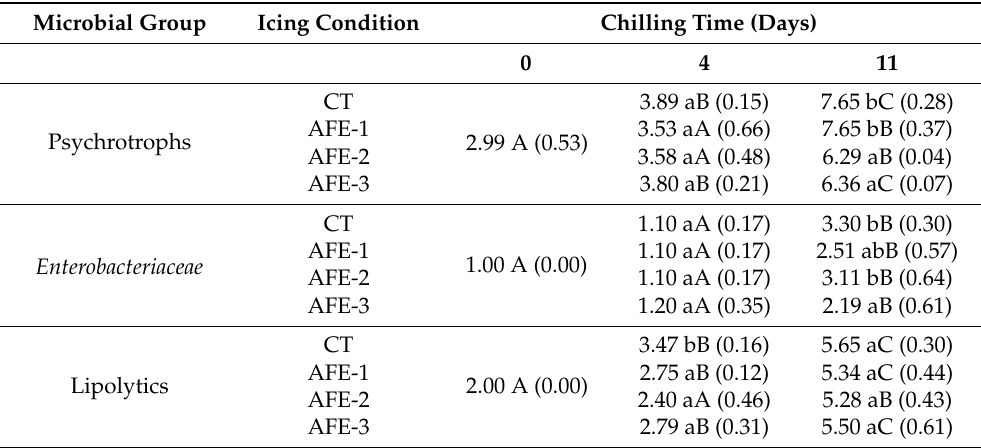
Table 4. Microbial development (log CFU · g − 1 muscle) * in chilled mackerel subjected to different icing conditions